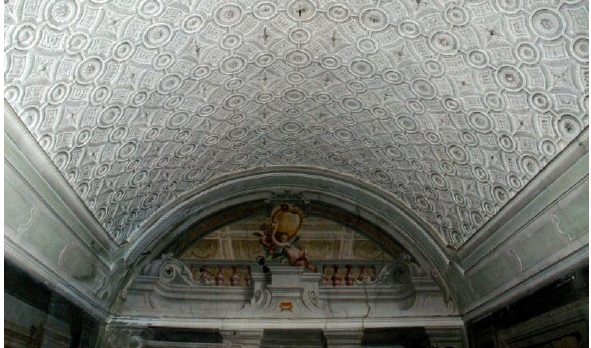
Figure 3. The vault of one minor